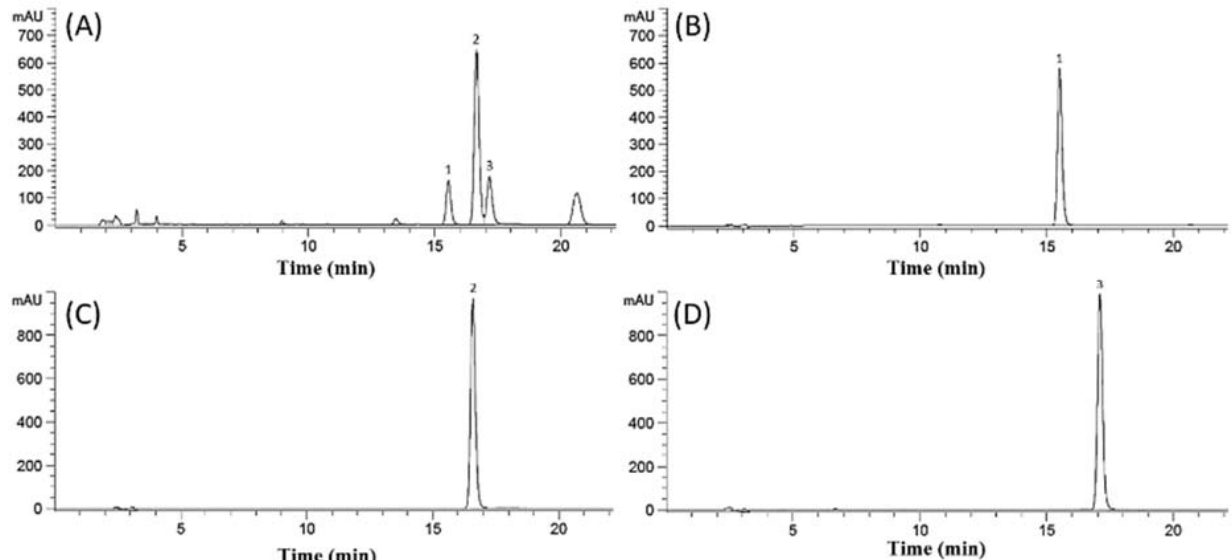
Figure 2. Chromatograms of Kaempferia parviflora extract (0.1 g/mL) and standard solutions (0.001 g/mL). ( A ) Extract of KP, ( B ) PMF, ( C ) DMF, and ( D ) TMF. Peaks: (1) PMF, (2) DMF, and (3) TMF. Abbreviations: KP, Kaempferia parviflora ; DMF, 5,7-dimethoxyflavone; TMF, 5,7,4 (cid:48) -trimethoxyflavone; and PMF, 3,5,7,3 (cid:48) ,4 (cid:48)